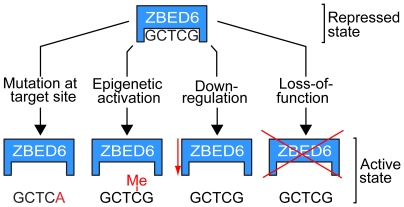
Proposed model for ZBED6 action.ZBED6 repression may be released by (i) germline or somatic mutations at target sites, (ii) methylation (Me) of the CpG site in the binding motif, (iii) down-regulation of ZBED6 expression, or (iv) loss-of-function mutations in ZBED6.